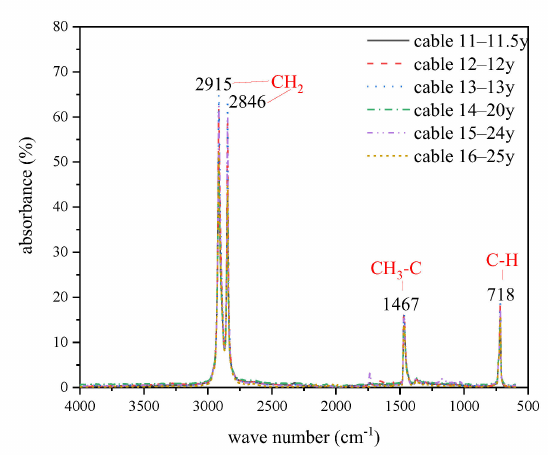
Figure 5. FTIR spectrums of XLPE samples.